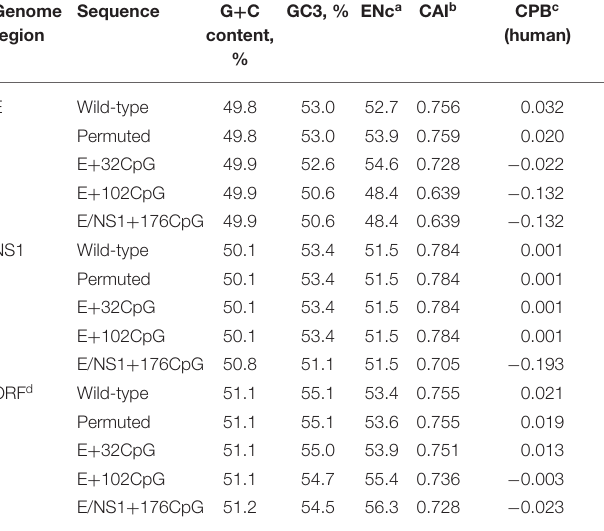
TABLE 2 | Genomic analysis of CpG-recoded ZIKV variants. Genome